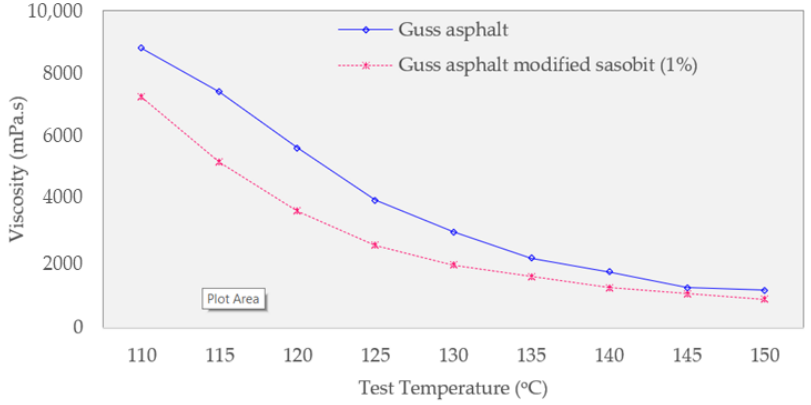
Figure 7. Viscosity analysis of guss asphalt mixtures.